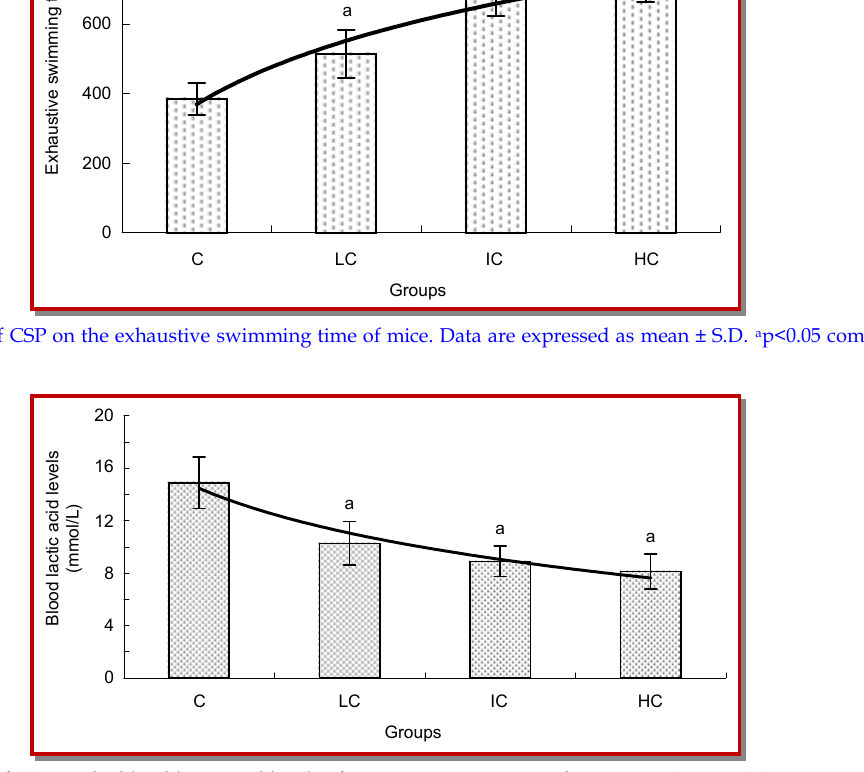
Figure 2: The effects of CSP on the blood lactic acid levels of mice. Data are expressed as mean ± S.D. a p<0.05 compared with con- trol